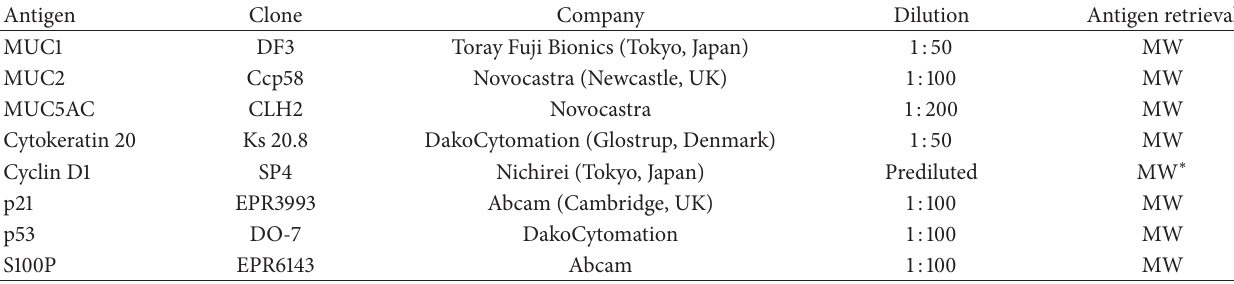
Table 1: Primary antibodies used for immunohistochemical